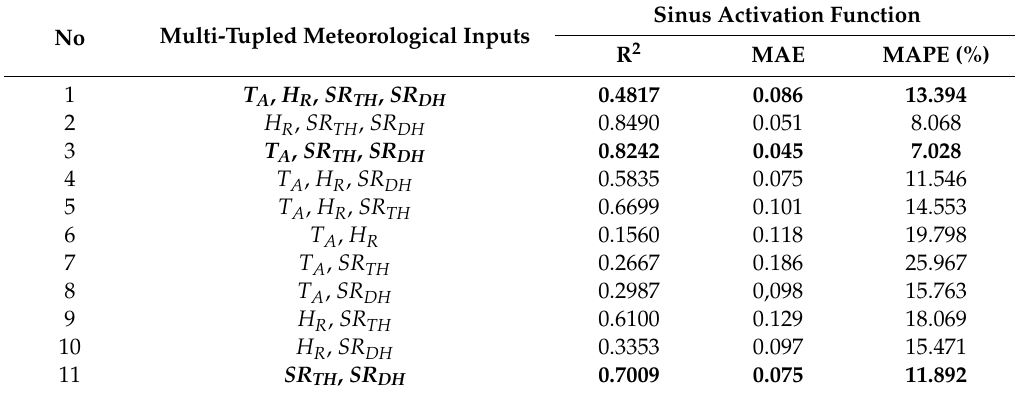
Table 6. Daily photovoltaic power prediction results of the WOA-MLP method, which used the sinus activation